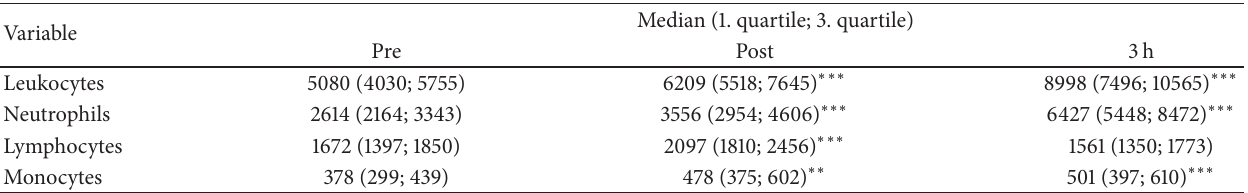
Table 2: Leukocytes, neutrophils, lymphocytes, and monocytes counts are shown in cells/ 𝜇 L. Displayed is the median with the 1. and 3. quartile in parentheses. ∗∗ 𝑝 < 0.01 and ∗∗∗ 𝑝 < 0.001 indicate significant differences from